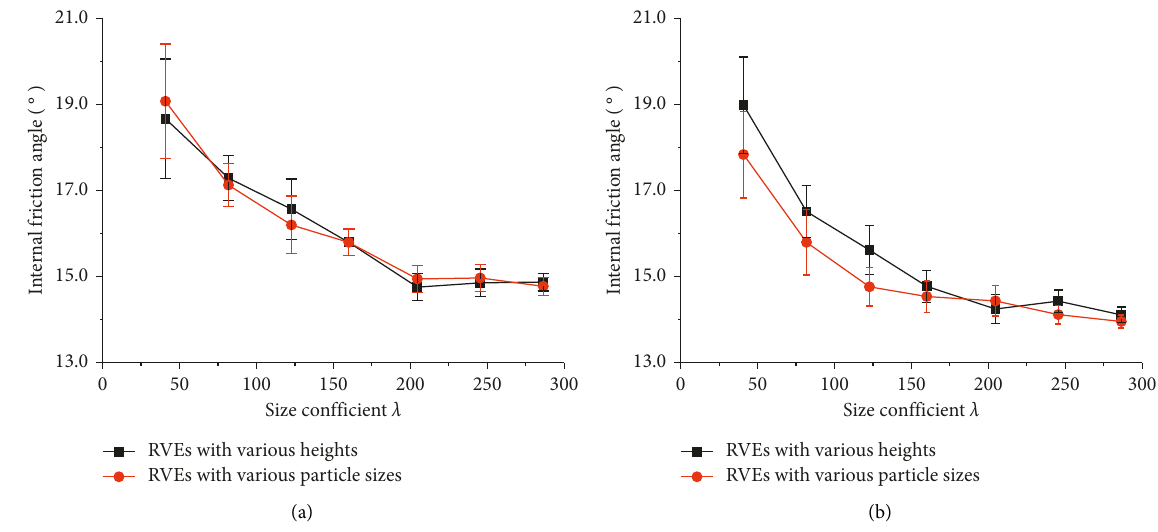
Figure 7: Internal friction angle-size coefficient relationship of RVEs with various heights and particle sizes. (a) At 0g gravity. (b) At 5g